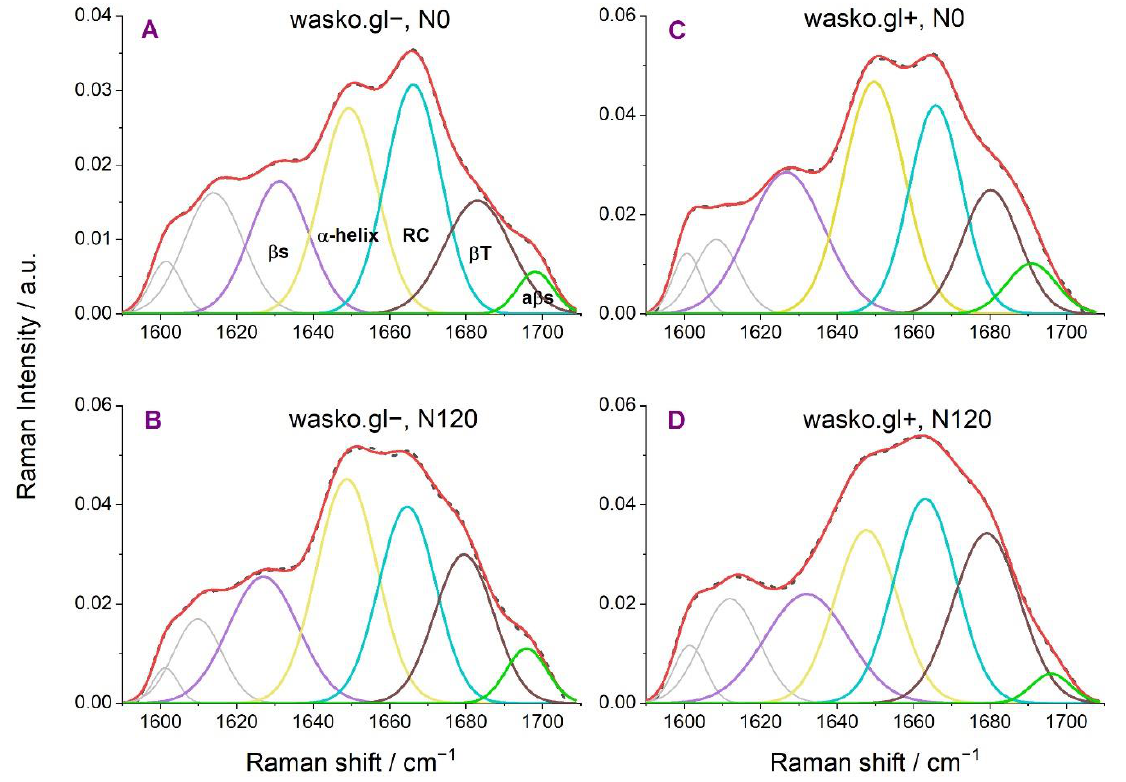
Figure 5. Curve fitting of the Raman spectrum in the range of amide I obtained for gliadin proteins isolated from flour of the wheat lines wasko.gl − and wasko.gl+. Spectra ( A , B ) show results obtained from flour of wasko.gl − wheat kernels under minimal (N0) and maximal (N120) nitrogen fertilization, respectively. Spectra ( C , D ) show results obtained from flour of wasko.gl+ wheat kernels under minimal (N0) and maximal (N120) nitrogen fertilization, respectively. The experimental spectra are represented by dashed black lines and the calculated ones are represented by solid red lines. The calculated profiles in the panels were determined as the sums of the individual curve-fitted components, namely, β -sheet (1627–33 cm − 1 —violet), α -helical (1648–50 cm − 1 —yellow), random coil (1663–1666 cm − 1 —blue), β -turn (1680–83 cm − 1 —brown), and a β -sheet (1691–98 cm − 1 —green) structures. Table 4. The estimated content of the secondary structure of gliadin proteins isolated from flour obtained from kernels of wasko.gl − and wasko.gl+ wheat lines under minimal (N0) and maximal (N120) dose of nitrogen fertilization. N ≥ 3, SD < 5%. wasko.gl − (N0) wasko.gl − (N120) wasko.gl+ (N0) wasko.gl+